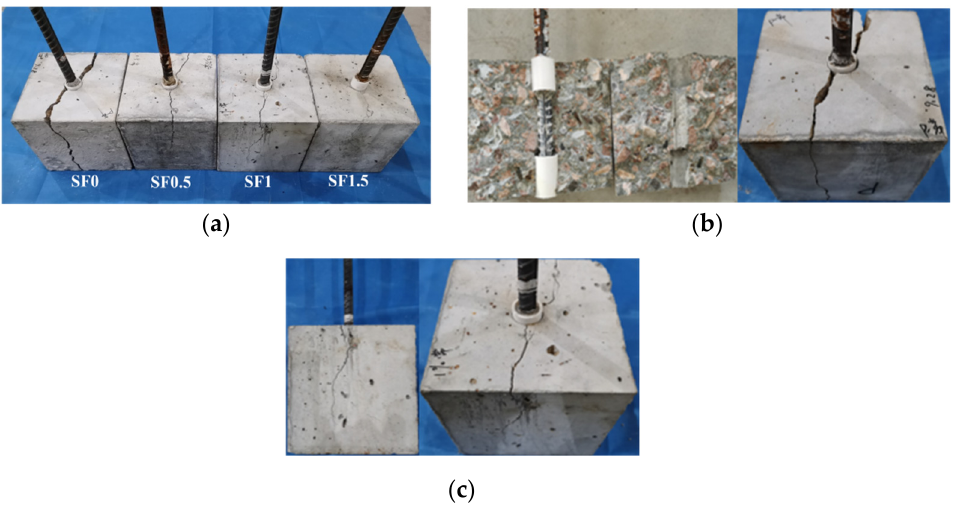
Figure 7. ( a ) Comparison of failure modes, ( b ) splitting failure pattern, and ( c ) split-pullout failure patterns of specimens.